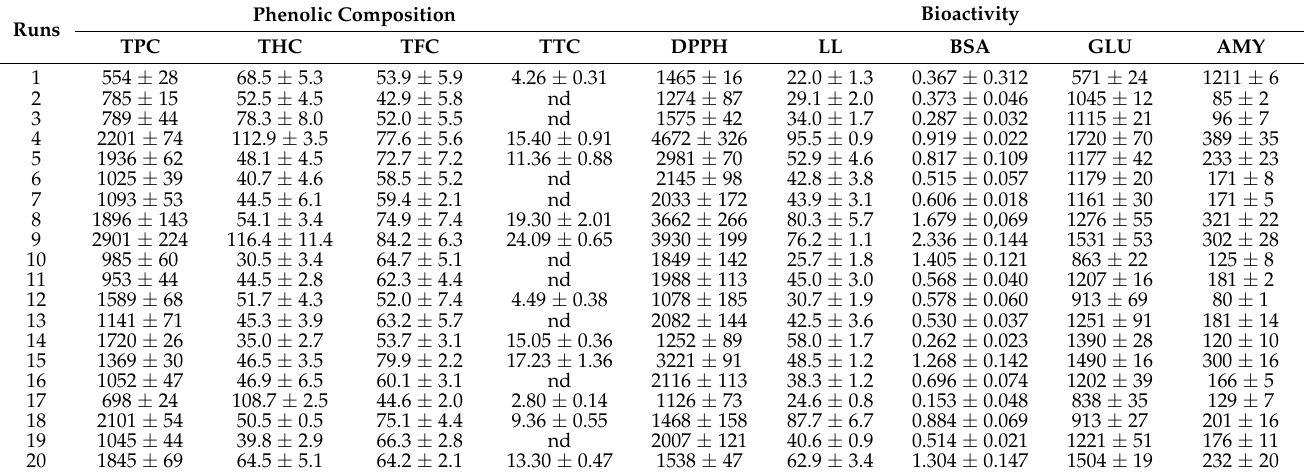
Table 2. Phenolic composition and bioactivity of grape pomace infusions as affected by brewing variables.